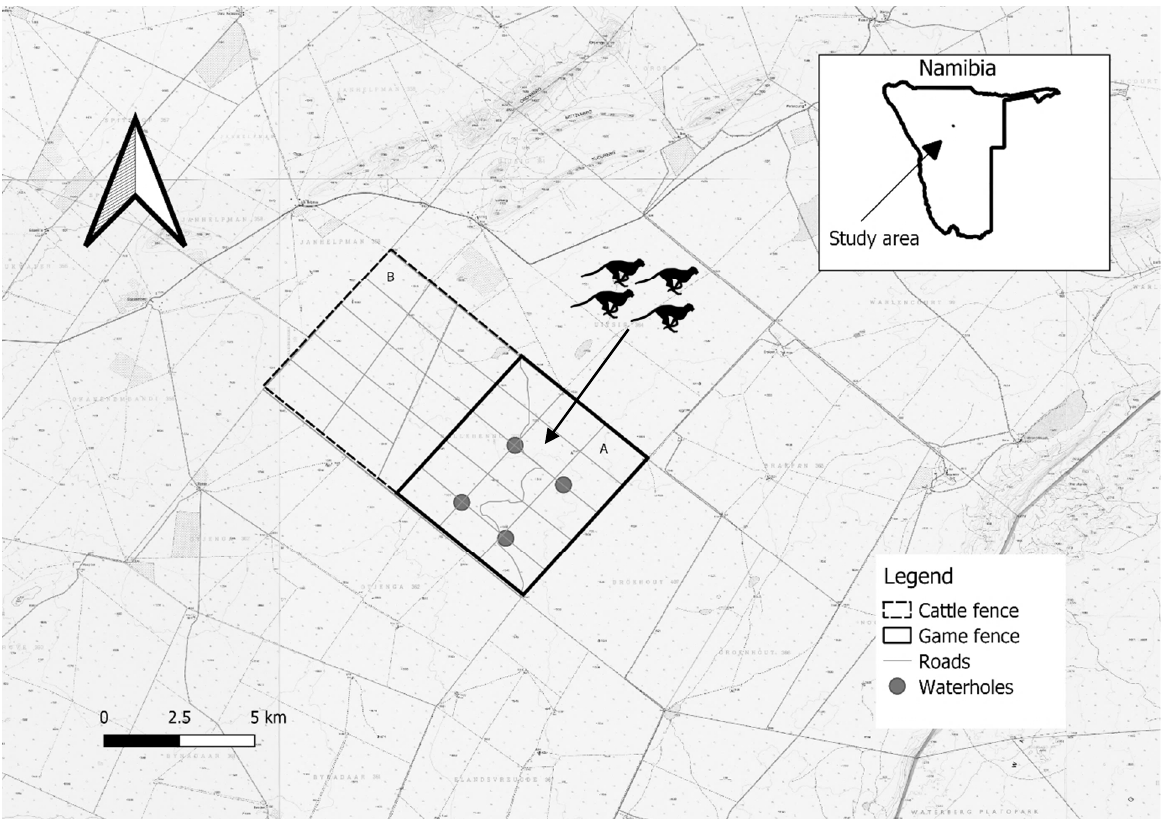
Figure 1. Map of Bellebenno game reserve, Namibia with four man-made waterholes, dirt roads, and game fence included. The study occurred in section A, which is a managed as a reserve, whereas section B operates as a cattle farm.